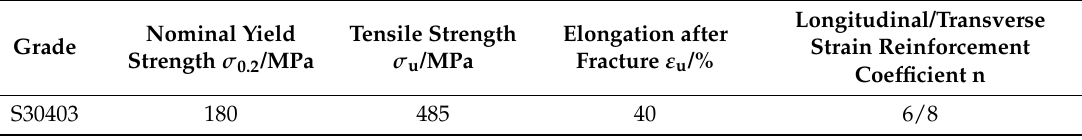
Table 2. Mechanical properties specified by GB/T